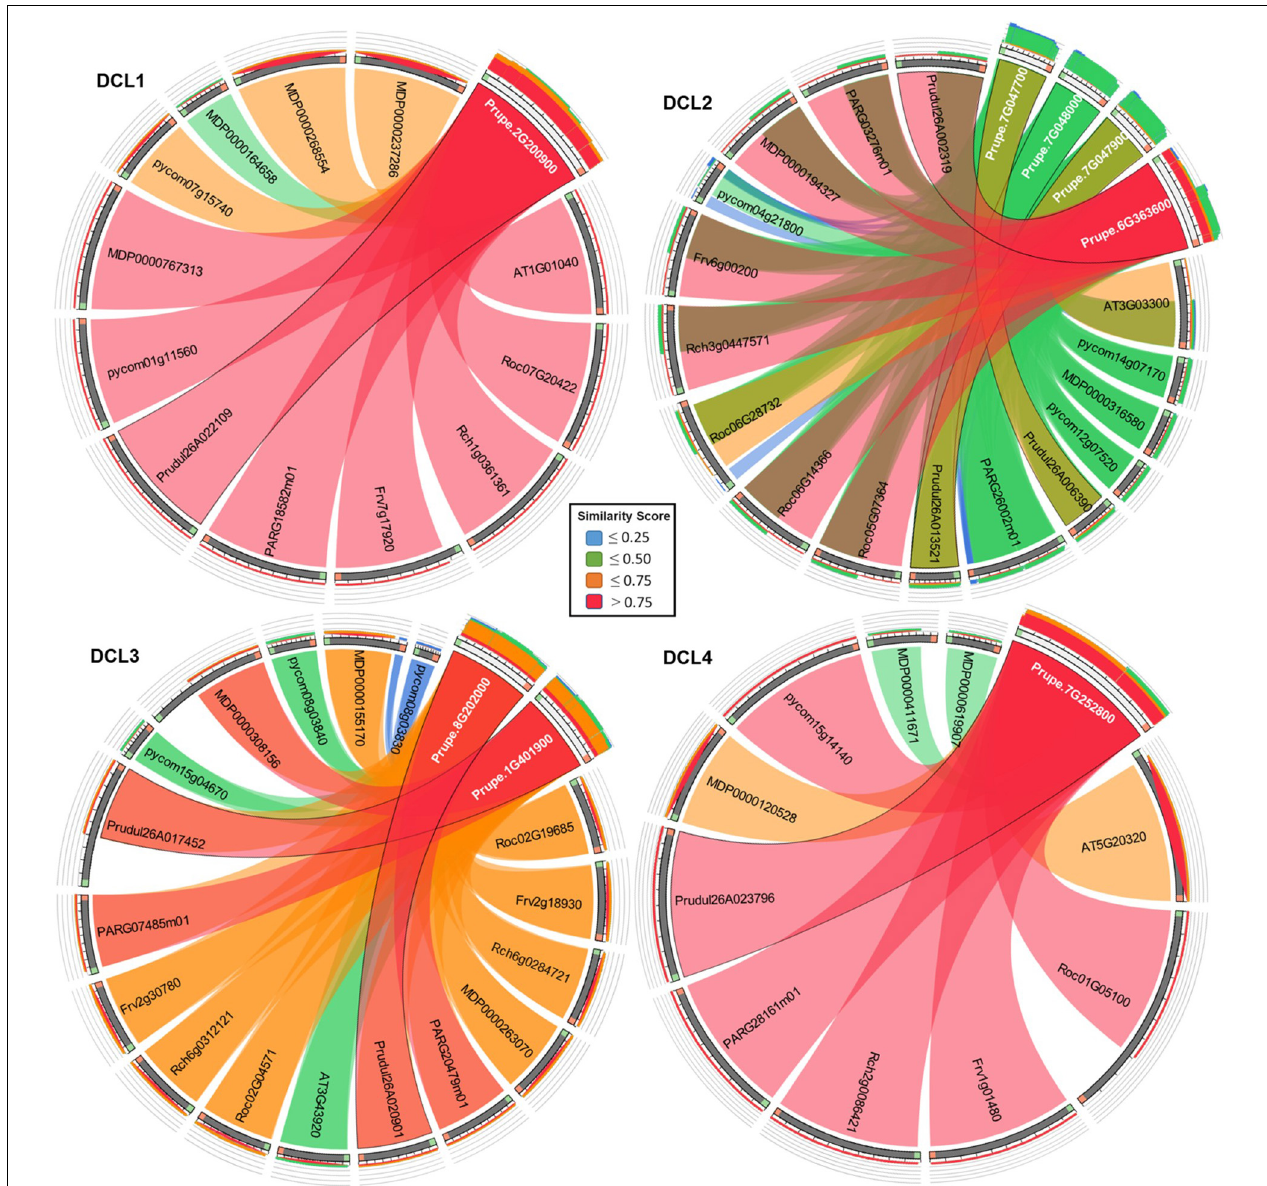
FIGURE 3 | Circos plot of protein similarity among the identified DCLs genes copies. Rosaceae DCLs genes copies were mapped using BLASTP data on the different species which were anchored to the PrupeDCLs. Similarity score is indicated on the inner box and the highlighted arcs in the center of the circos link homologous DCLs genes. P -value <